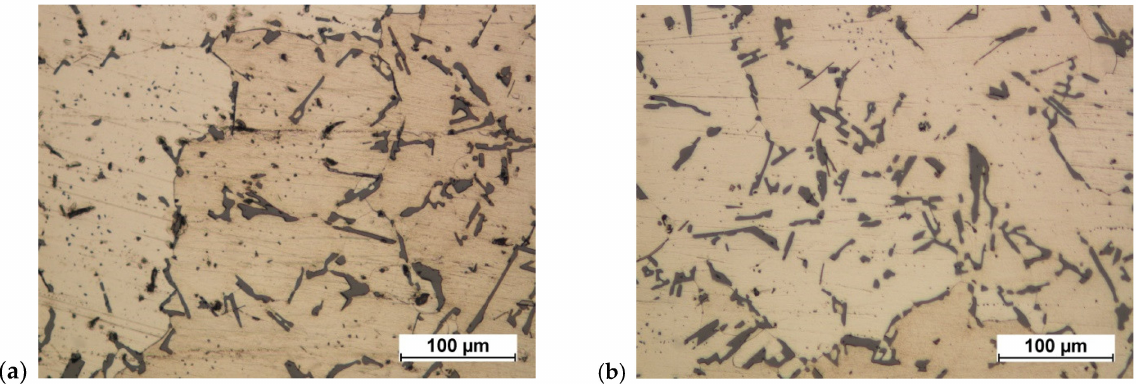
Figure 32. Cast of a connecting rod preform made of AB-71100 aluminum alloy after homogenization: ( a ) variant 1, ( b ) variant 2.